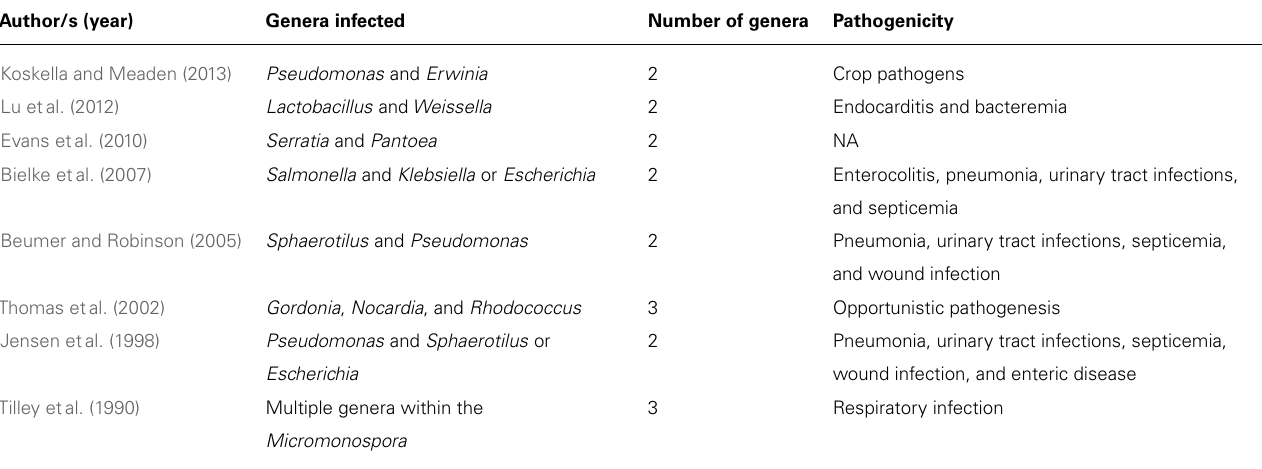
Table 1 | Examples of phages isolated from the environment capable of infecting across